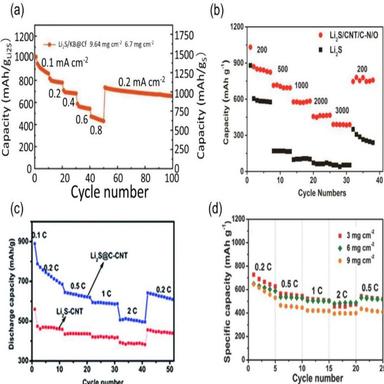
The rate capability of (a) Li2S/KB@Cf , (b) Li2S-C-N-O@CNT , (c) Li2S@C-CNT, and (d) Li2S@NCNF . Reproduced from Refs. with permission from Elsevier, Royal Society of Chemistry, and Wiley.